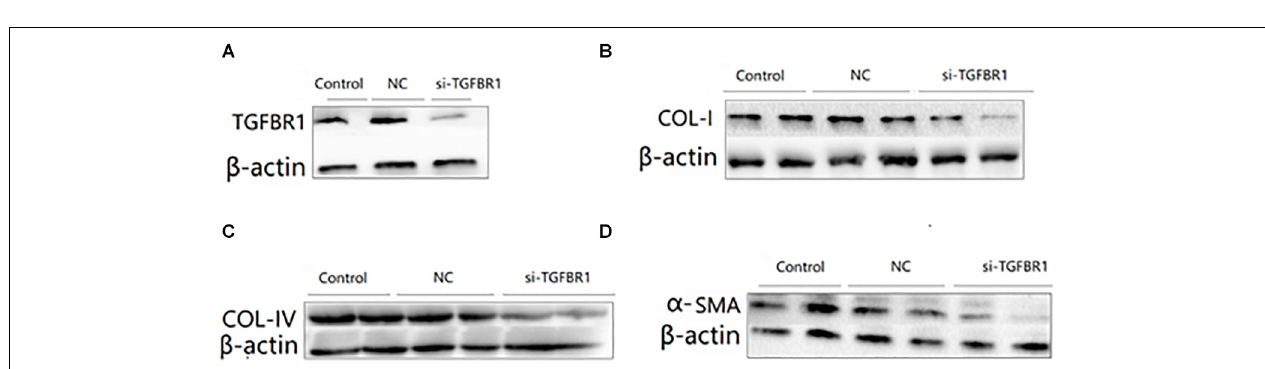
FIGURE 5 | miR140-5p negatively regulated TGFBR1 expression. (A) Bioinformatics analysis of predicted interactions of miR-140-5p with its binding sites in TGFBR1 3’UTR. (B) Luciferase activity was measured by dual-luciferase reporter assay. Luciferase activity was normalized to Renilla luciferase activity. Overexpression of miR-140-5p significantly increased luciferase activity in cells transfected with TGFBR1 3’ UTR-WT, but not TGFBR1 3’ UTR-NC or TGFBR1 3’ UTR-mut. (C) HK2 cells transfected with miR-140-5p or NC were harvested and TGFBR1 protein level was analyzed by western blot. β -actin was detected as a loading control. Data was presented as mean ± SD of three experiments. Control: no transfection treatment, Negative control (NC): cells transfected with scrambled oligonucleotide. ∗∗ P < 0.01 versus Control.